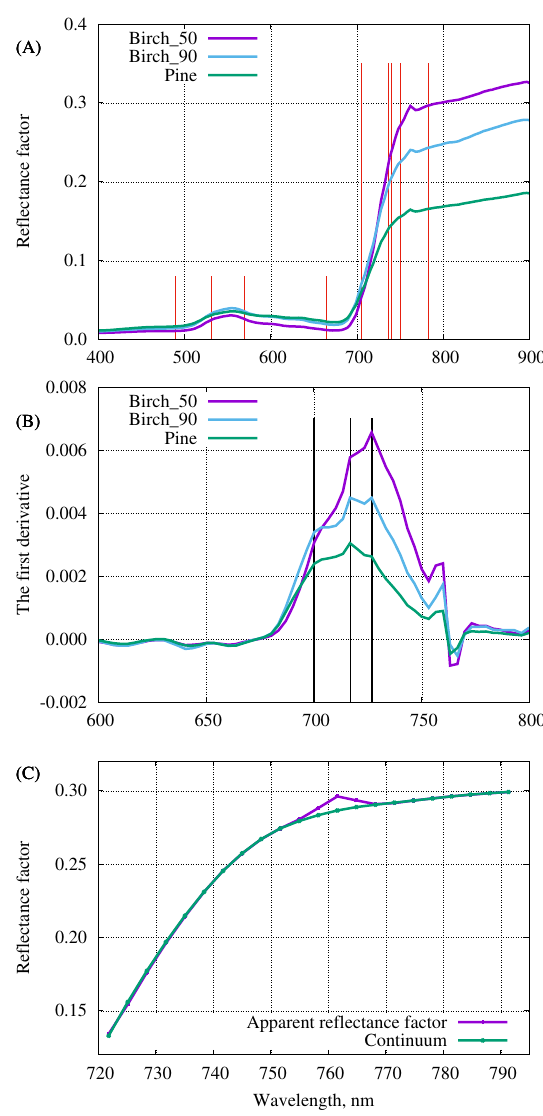
Figure 3. ( A ) Some examples of reflectance spectra from two birch dominated stands (50 and 90 years old) and a pine dominated stand. The spectral resolution (FWHM) is 10 nm and the spectral sampling interval 3.3 nm. Vertical lines denote spectral bands selected for further analysis in current study as single band reflectance factors and for calculating vegetation indices. ( B ) The first derivative of reflectance spectrum. Vertical lines denote the locations of peaks for red edge inflection points around 700, 717 and 727 nm. ( C ) An example of fitting continuum for the estimation of in-filling of the O 2 -A Fraunhofer line around 760